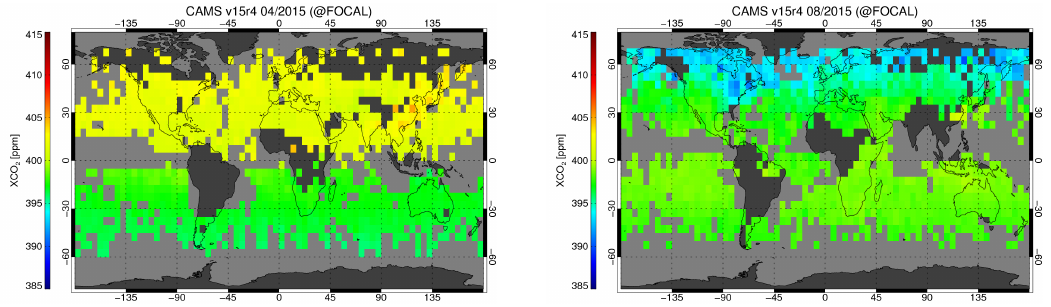
Figure 13. Monthly mean XCO 2 at 5° × 5°. ( Top ) FOCAL v06. ( Bottom ) CAMSv15r4 sampled as FOCAL. ( Left ) April 2015. ( Right ) August 2015.